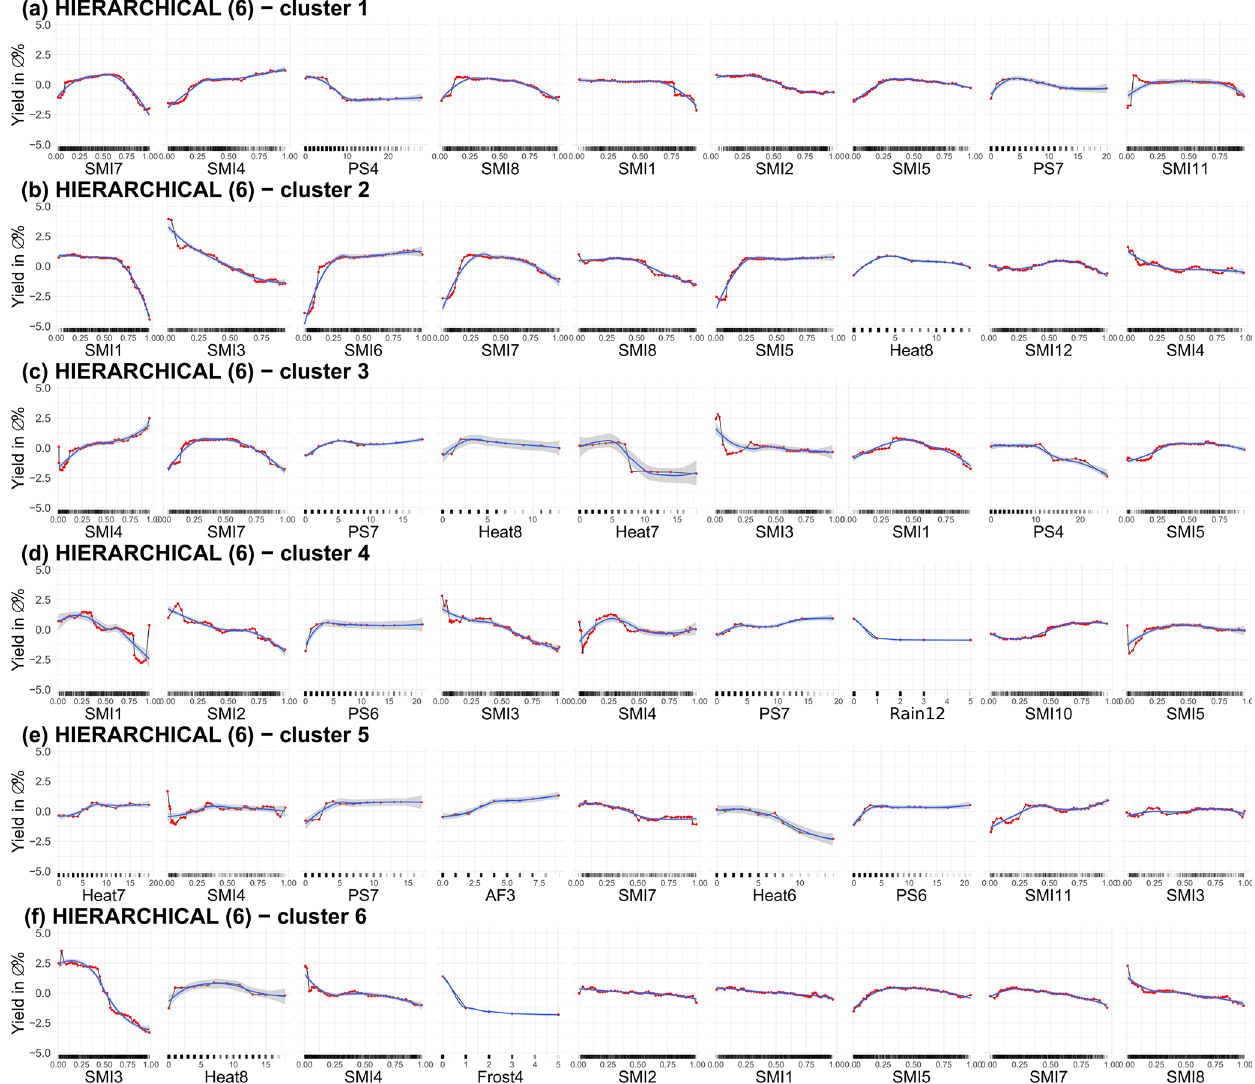
Figure A6. ALE plots for the second best combination of cluster algorithm and cluster size (HIERARCHICAL with six clusters) for a soil moisture index configuration that only considers the uppermost 25cm. For the six clusters, the nine ALE plots with the highest feature importance are shown. The importance ranking is established with 50 repetitions. We have chosen a grid size of 50 to estimate the ALE plots, which allows us to reveal the true complexity of the model at the expense of shakiness. Therefore a non-linear smoothing function (LOESS – locally estimated scatterplot smoothing) is added in blue (with the confidence interval in grey). SMI represents the soil moisture index for the uppermost 25cm of the soil column, PS stands for days without rain in a given month, Heat stands for days with a maximum temperature of more than 30 ◦ C, and Rain represents the days of precipitation higher than 30mm/d. The number indicates the month; October (10) to December (12) refers to the year